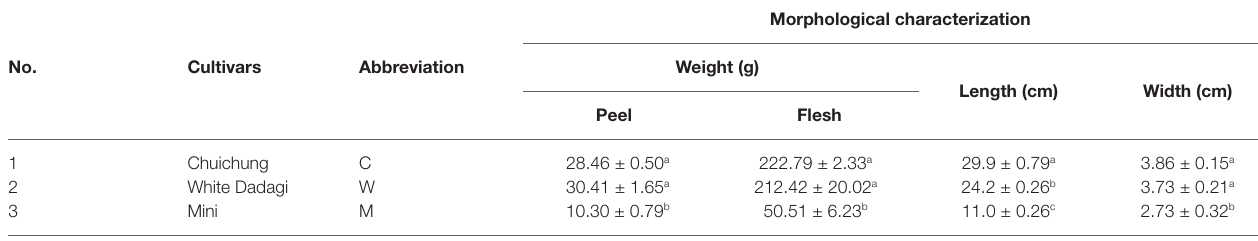
TABLE 1 | Data on the morphological characterization of the three cucumber cultivars.